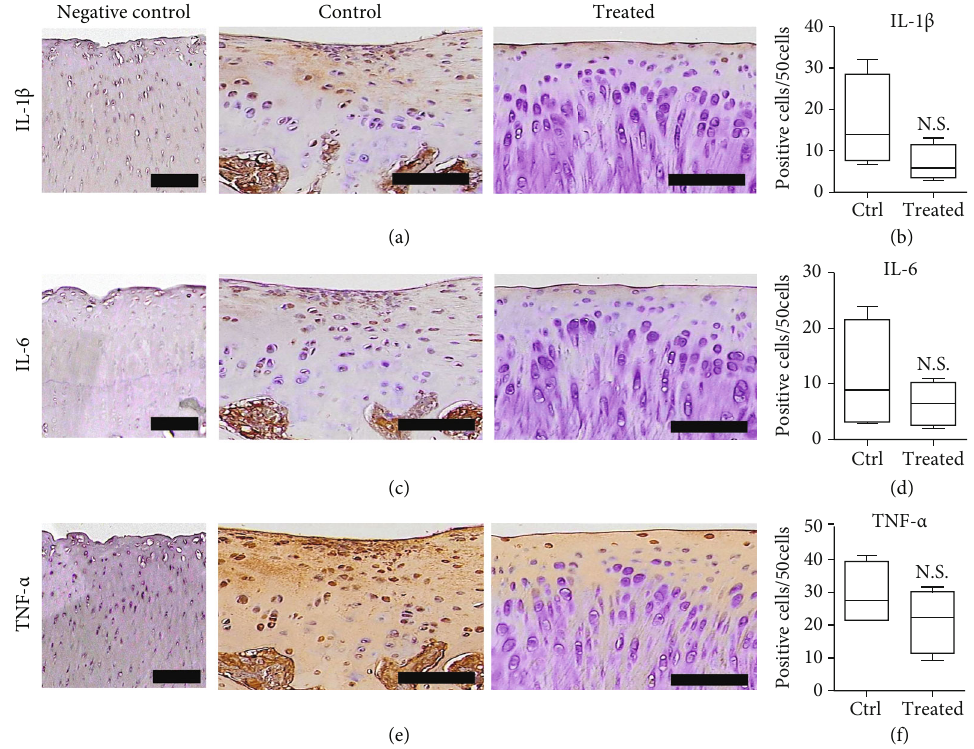
Figure 7: Immunohistochemistry of in fl ammatory markers TNF- α , IL1- β , and IL6 in the cartilage after 12 weeks of experiments. (a) Representative image of IL-1 β in the cartilage of normal cartilage (negative control), normal saline control, and treated knee. Scale bar = 100 μ m . (b) The 1 × 10 7 HUCMSC+HA-treated joints show no signi fi cantly higher content of IL-1 β than the normal saline control joints ( n = 4 ). (c) Representative image of IL-6 in the cartilage of normal cartilage (negative control), normal saline control, and treated knee. Scale bar = 100 μ m . (d) The 1 × 10 7 HUCMSC+HA-treated joints show no signi fi cantly higher content of IL-6 than the normal saline control joints ( n = 4 ). No di ff erences are noted between both groups. (e) Representative image of TNF- α in the cartilage of normal cartilage (negative control), normal saline control, and treated knee. Scale bar = 100 μ m . (f) The 1 × 10 7 HUCMSC+HA-treated joints show no signi fi cantly higher content of TNF- α than the normal saline control joints ( n = 4 ). No statistical di ff erences are noted between both groups. Ctrl: